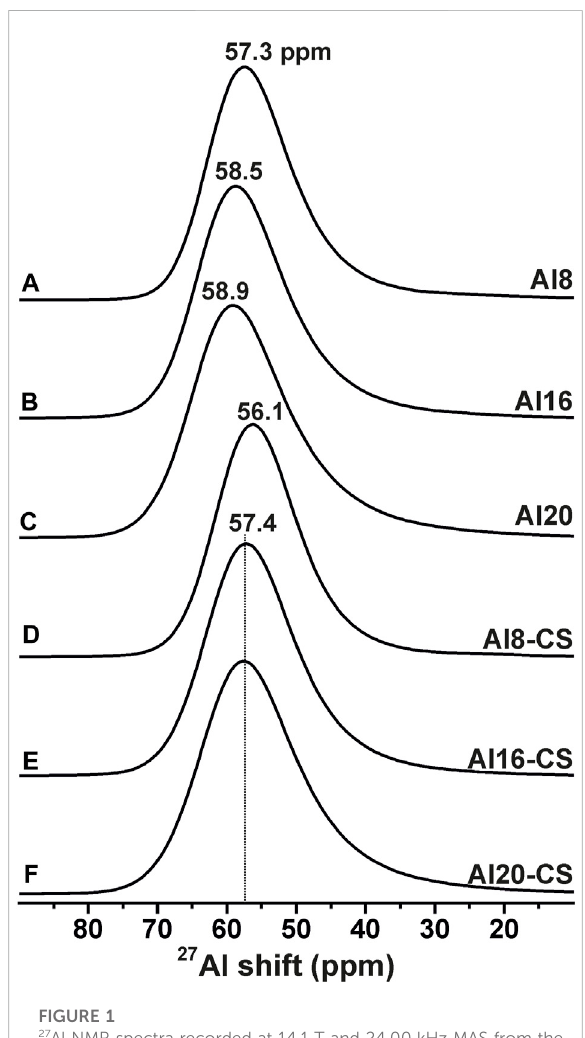
FIGURE 1 27 Al NMR spectra recorded at 14.1 T and 24.00 kHz MAS from the Na 2 O – CaO – (Al 2 O 3 ) – SiO 2 glasses before (A – C) and after (D – F) exchange with K + ions. The peak maximum (in ppm) is indicated at the top of each NMR